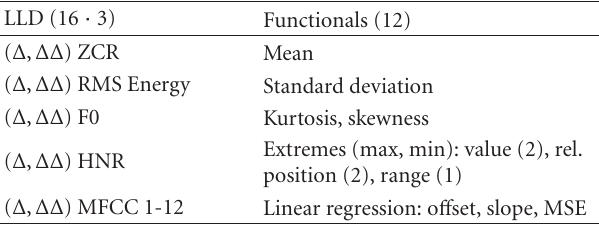
Table 6: Acoustic Low-Level Descriptors (LLD) and